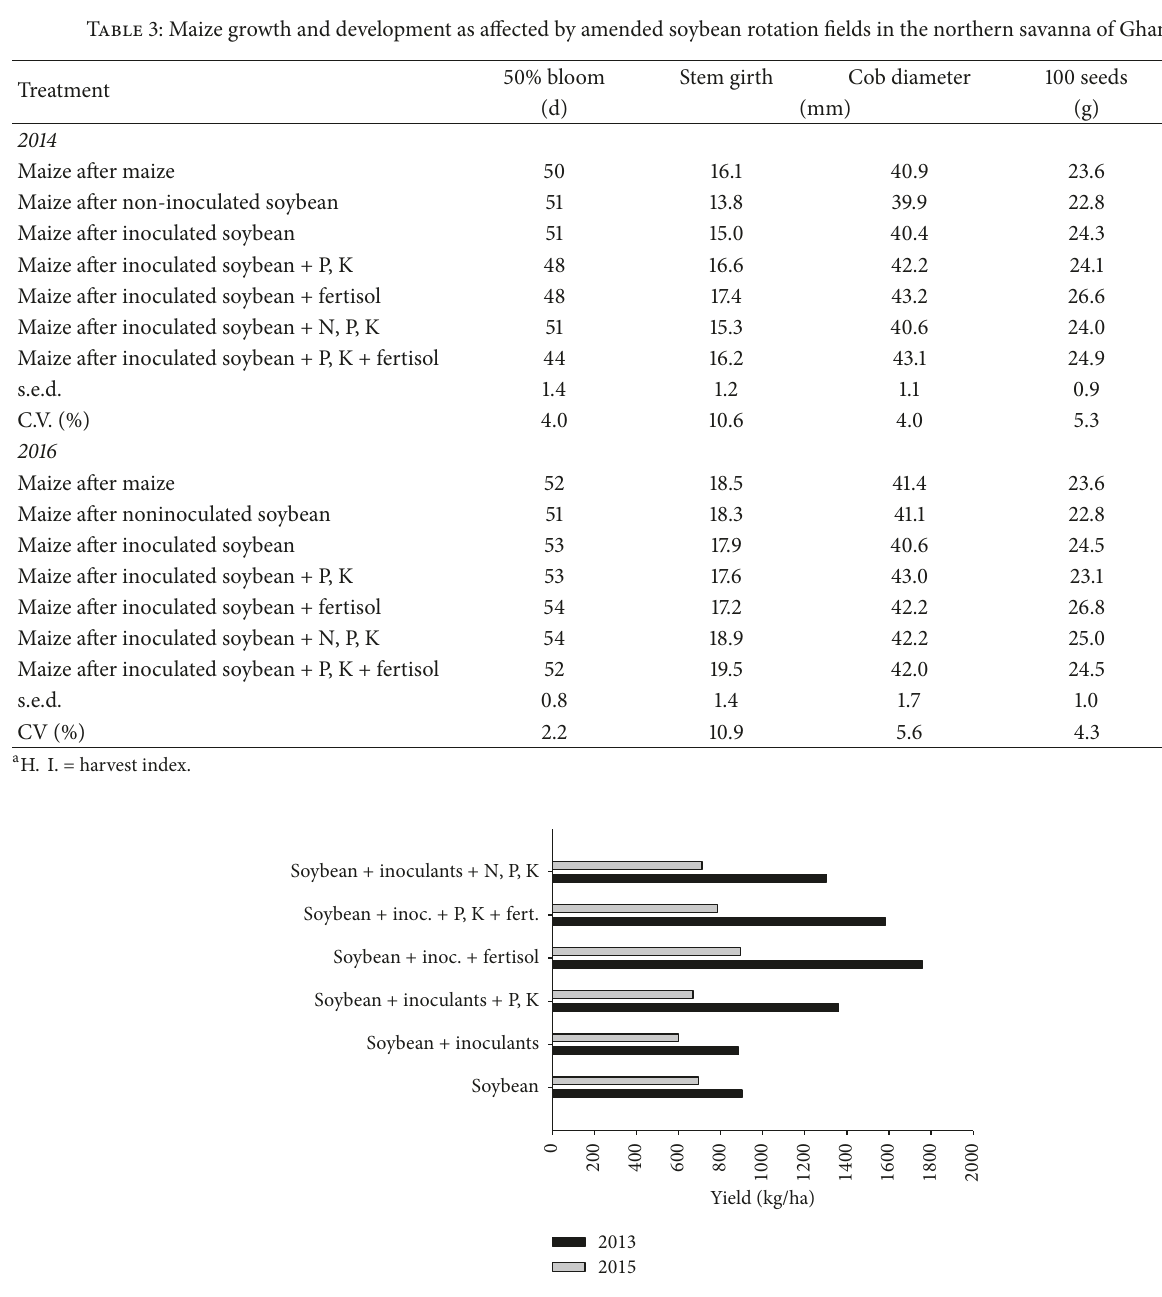
Figure 1: Grain yield of soybean as affected by soil amendments in the 2013 and 2015 cropping seasons in the northern savanna of Ghana. inoc.: inoculants and fert: